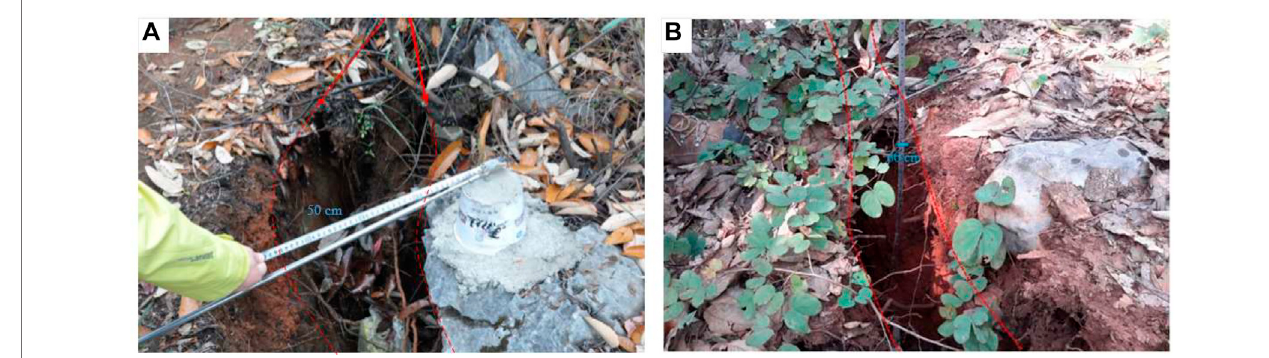
FIGURE 3 | Field measurement of the (A) fracture width and (B) depth.